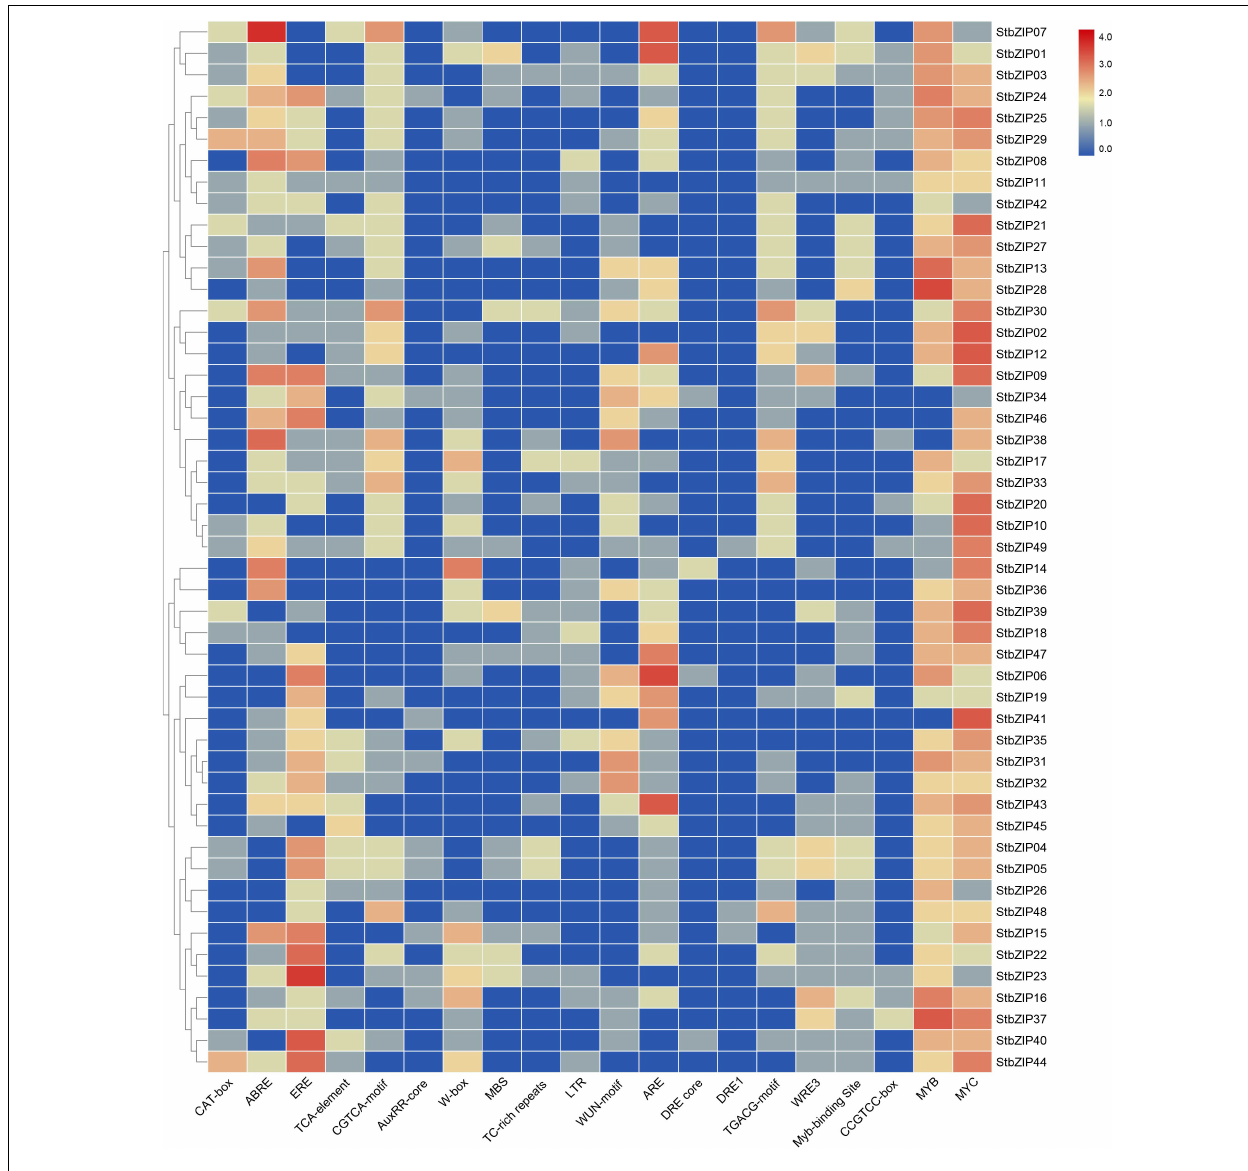
FIGURE 5 | Regulatory elements in the promoter regions of StbZIP